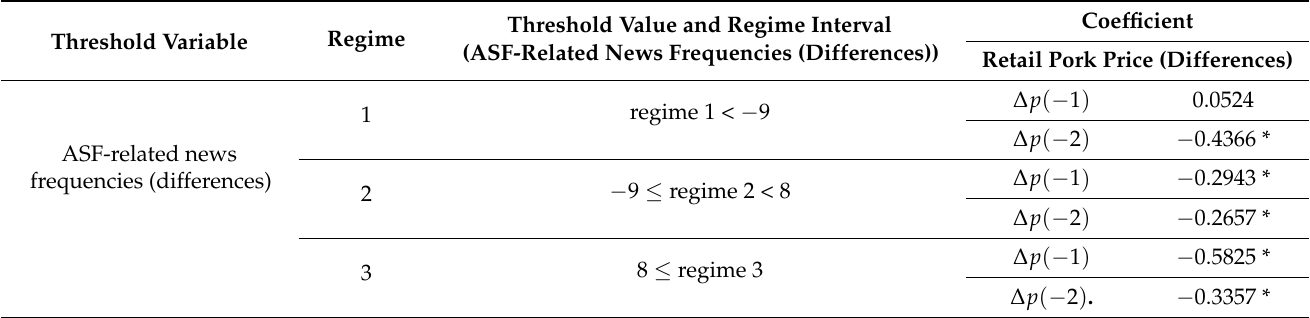
Table 3. Threshold Autoregressive Model of the African Swine Fever (ASF)-related News Frequency on Retail Pork Prices. Threshold Value and Regime Interval Threshold Variable Regime (ASF-Related News Frequencies (Differences))